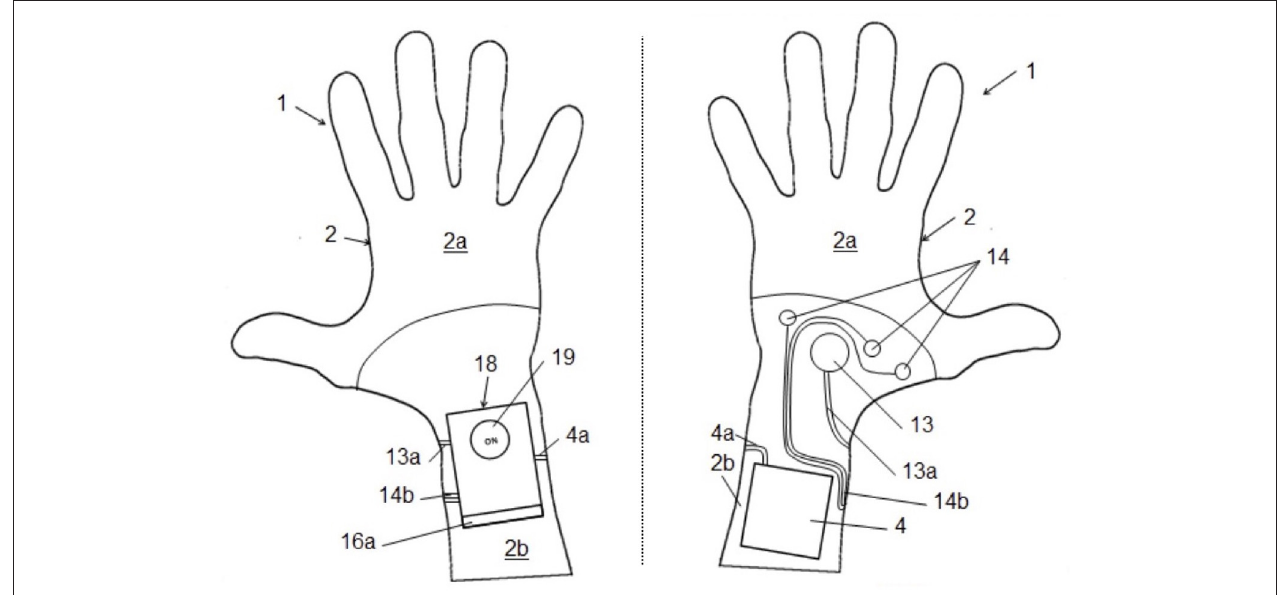
FIGURE 1 | Glove-specific functioning: glove prototype from the patent scheme. The numbers are referred to the details discussed in Supplementary Material